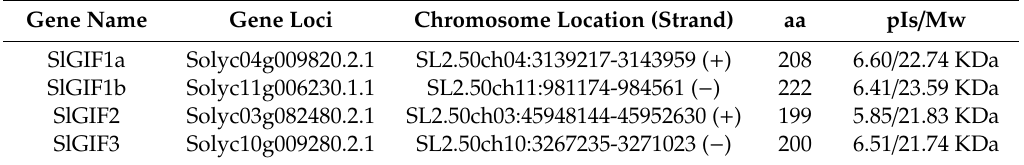
Table 1. Physico-chemical characteristics of the growth-regulating factors-interacting factor ( GIF ) gene family in